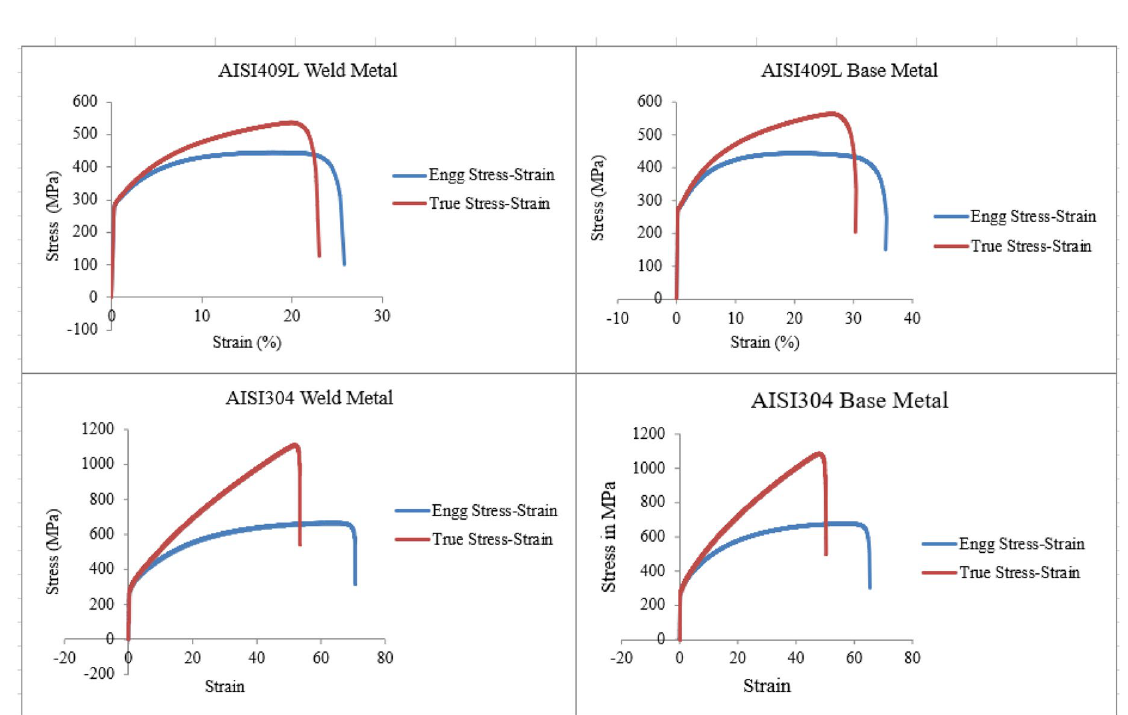
Fig. 10 Stress and strain path for AISI304 and AISI409L